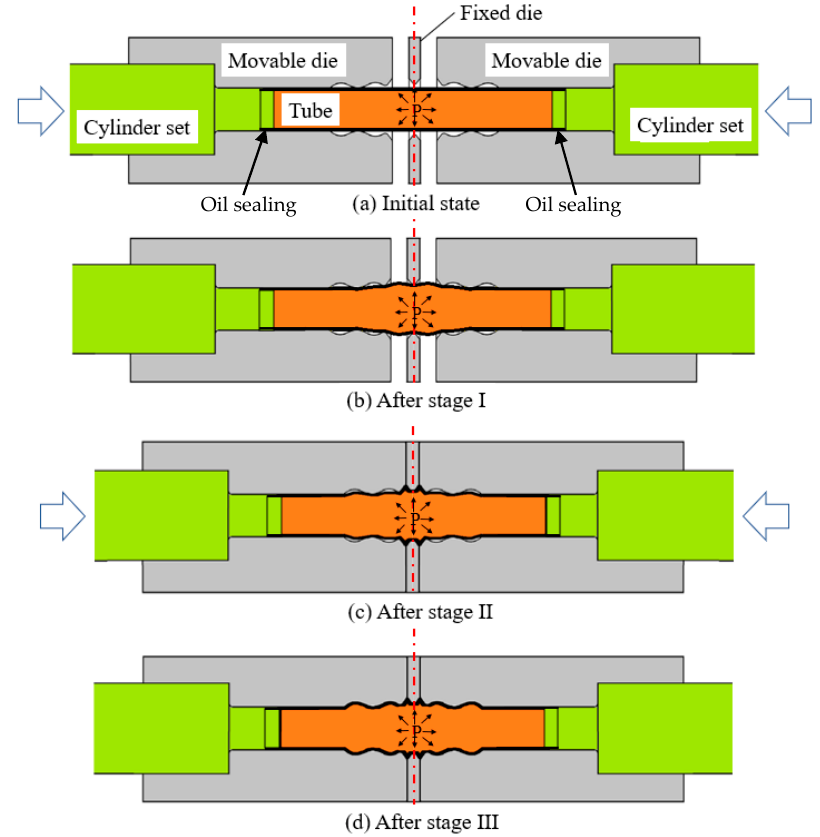
Figure 6. Forming procedures for feeding type 2 with one set of cylinders (Simultaneous movement of movable die and punch). ( a )–( d ): Initial State to After Stage III.